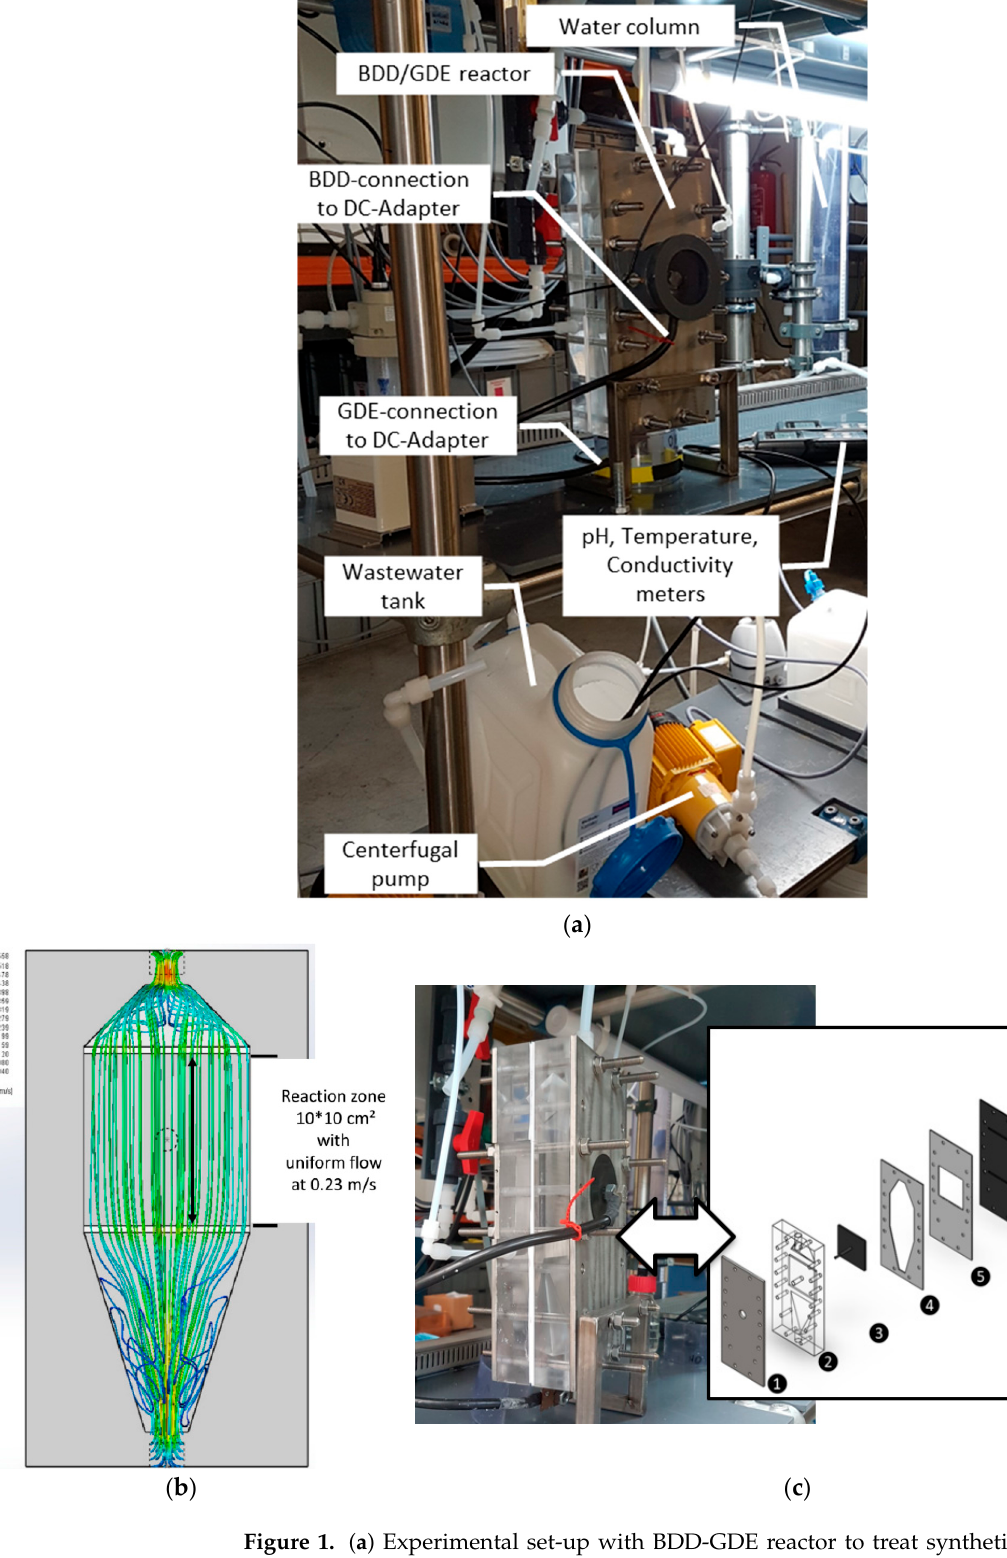
Figure 1. ( a ) Experimental set-up with BDD-GDE reactor to treat synthetic wastewater (SWW); ( b ) CFD-flow schema at the highest flow velocity (0.23 m/s); ( c ) BDD-GDE reactor: (1) front metal plate; (2) anode half-shell; (3) boron-doped diamond (BDD) electrode; (4) thin PTFE frame of anode side; (5) thick PTFE frame of cathode side; (6) gas diffusion electrode (GDE); (7) cathode half-shell; (8) front metal plate of cathode side.